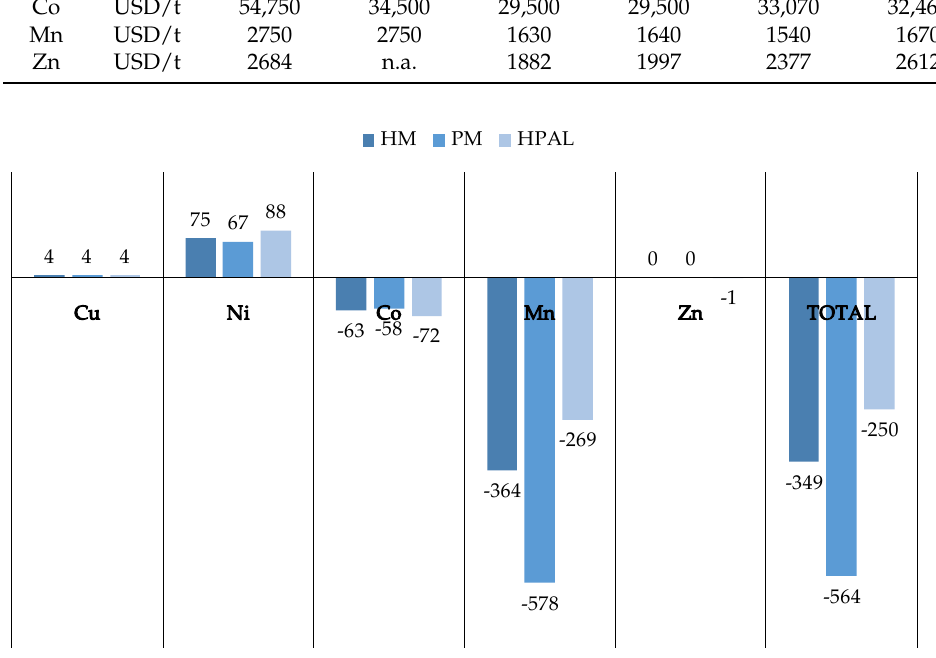
Figure 10. Change in annual revenue from the sale of metals in 11/2020 vs. 01/2019 in MUSD. Assuming (for this study) that prices valid in November 2020 remain unchanged (but discounted in the project duration according to the method of project discounted cash flow measured in constant prices), the loss of revenue from the sale of metals compared to the market conditions valid in January 2019 amounted to USD 3 billion for HPAL tech- nology (Figure 11).